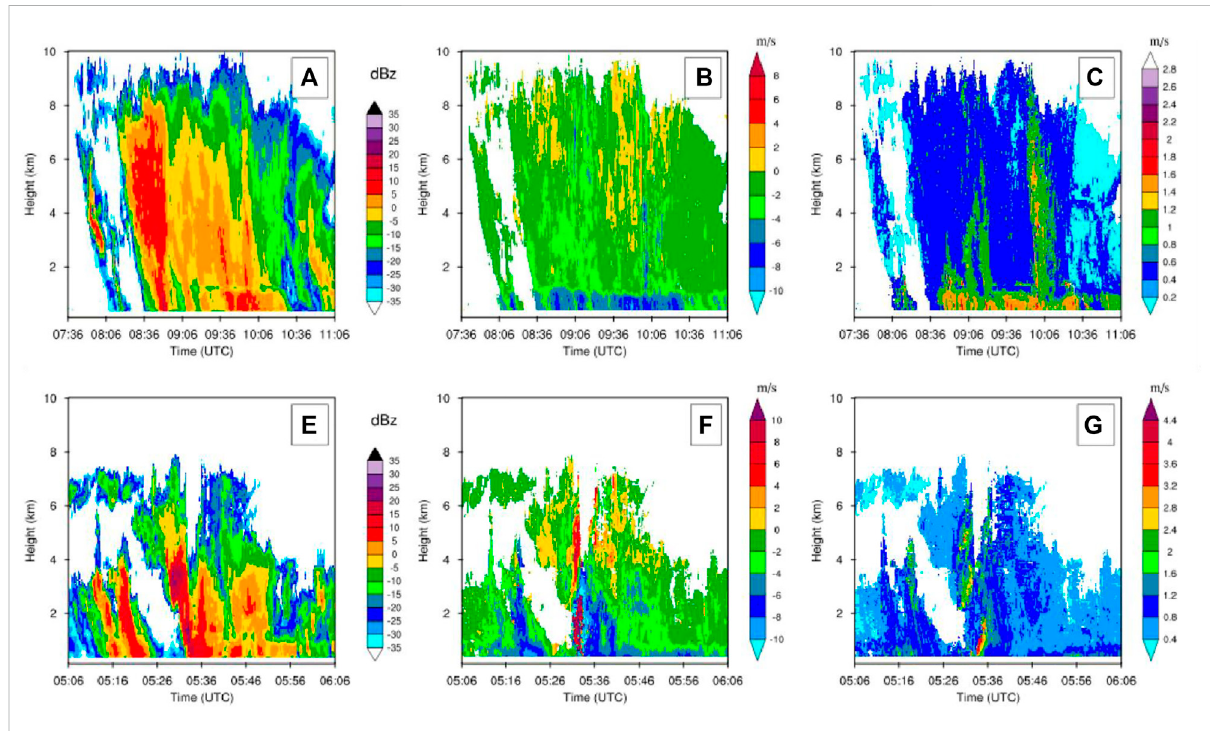
FIGURE 4 Cloud radar echo re fl ectivity, radial velocity, and velocity spectral width in PV thunderstorm (A,B,C) and in TC thunderstorm (E,F,G)